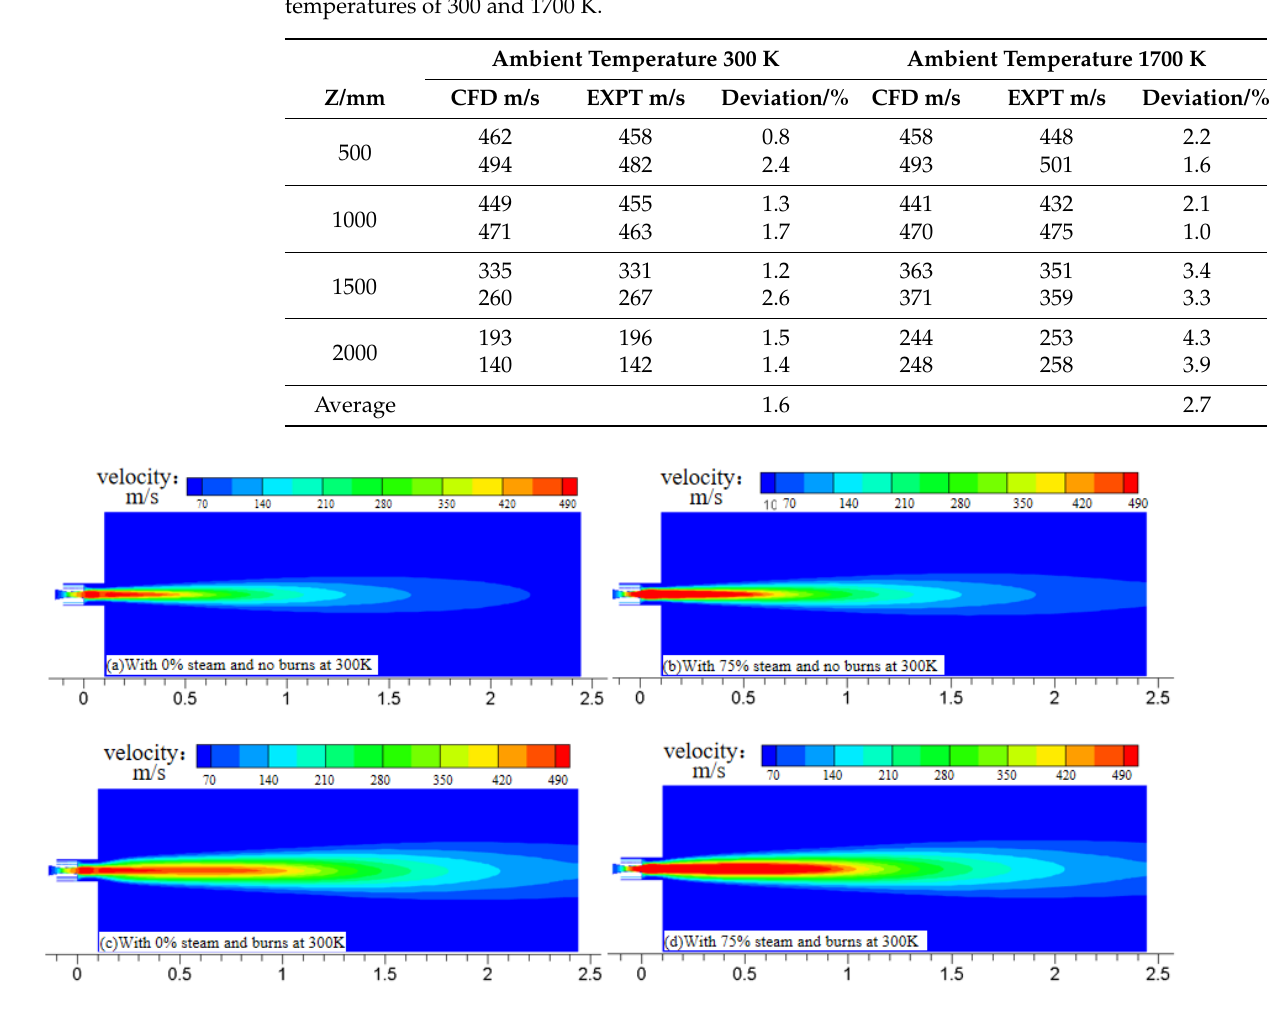
Figure 6. Axial velocity nephogram on the centerline of a coherent supersonic jet.